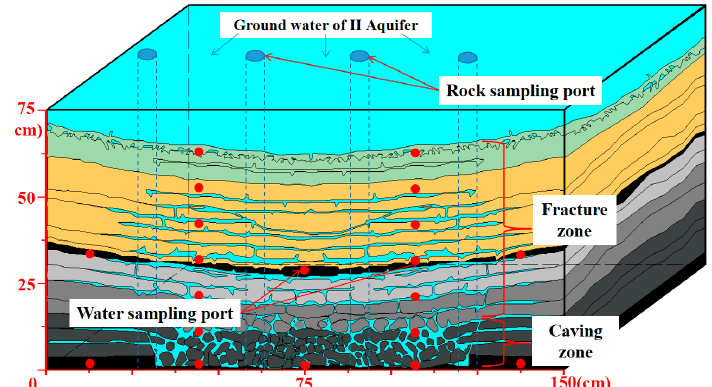
Figure 2. Schematic diagram showing the inflow, sampling ports, and goaf in the simulative box. For monitoring the goaf water, 20 ports, 1 cm in diameter, were cut out of the Plexi- glas wall to provide installation of the horizontal well as a water sampling port. Four sim- ulative vertical wells were settled in the box as rock sampling ports, which penetrated the goaf’s thickness with 75 cm length and 4 cm diameter to allow coring of the caving zone and fracture zone. Subsec According to the cross-sectional area (150 cm × 75 cm) of goaf and the average flow rate of groundwater in the II aquifer (0.3 cm/d), the influent water per day could be calcu- lated (3375 mL/d). Then, a peristaltic pump was used to control the influent quantity, 2.34 mL/min. At the 10th, 20th, 30th, 60th, 90th, 120th, 150th, 180th, 210th, 240th and 300th days, the groundwater was sampled from the horizontal wells to monitor rgw hydro- chemical characteristics of goaf water. Rock columns were removed from the vertical wells on the 30th, 90th, 180th, and 300th days. Then, each rock column was divided into seven parts corresponding to the goaf rock layers (3# coal, caving rock, fine sandstone, sandy mudstone, 2# coal, medium sandstone, mudstone) so that the mineral content changes i each rock layer during the simulative experiment could be analyzed. In addi- tion, the composition of the microbial community attached to the rock surface in goaf could also be detected. The groundwater from the II aquifer was loaded into five sterilized polyethylene drums (25 L), transported to the laboratory at − 4 °C, and stored at − 4 °C until injected into the experimental setup. The core of each rock layer was taken by drilling and processed